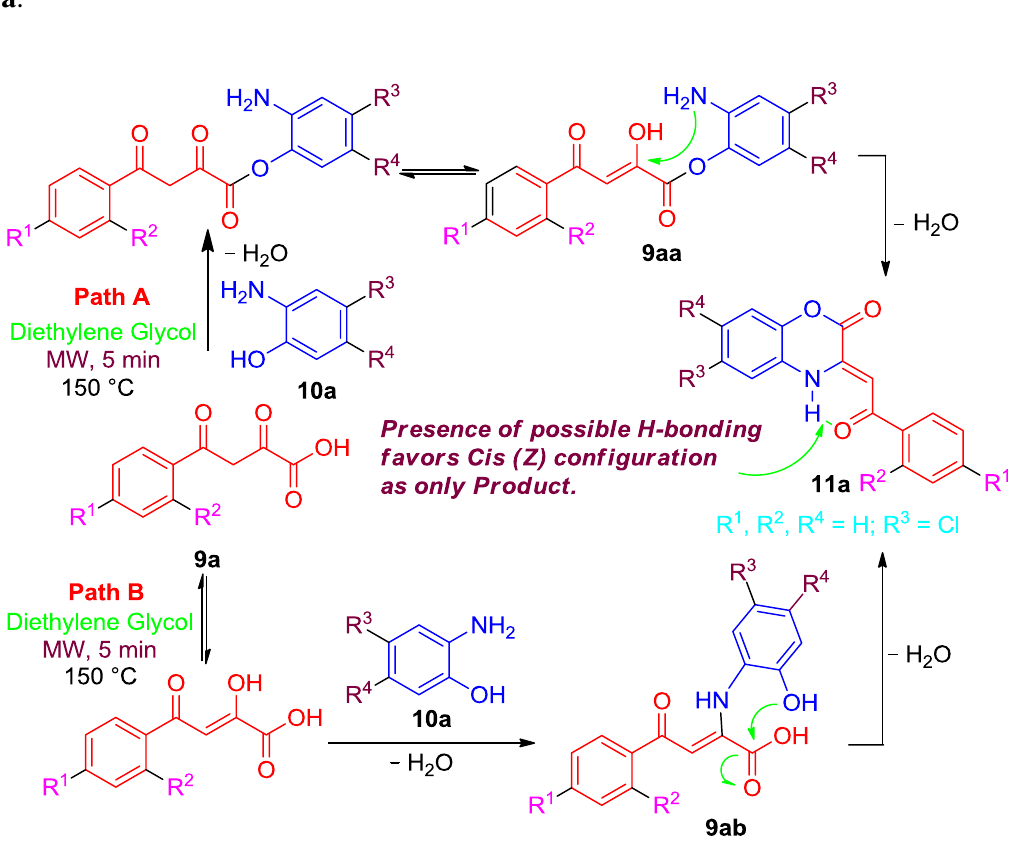
Figure 1 . Possible pathway for the formation of 2-oxo-benzo[1, 4] oxazine 11a